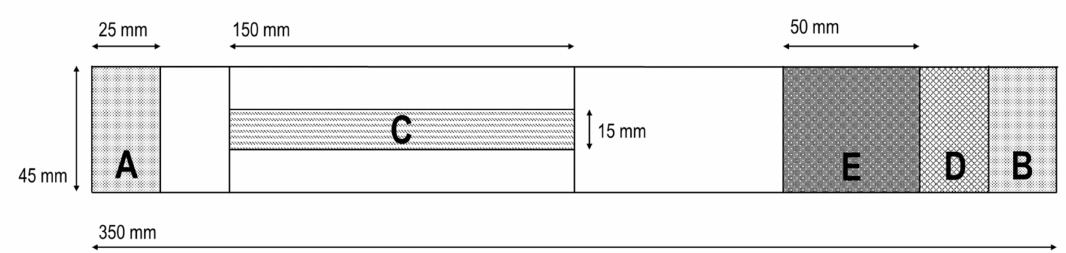
Figure 1. Sample preparation and tests from cut lamellae: ( A ) pre-thermo-hydro mechanical (THM) treatment density and moisture content (MC) tests, ( B ) post-THM treatment density and MC test, ( C ) modulus of elasticity (MoE) and modulus of rupture (MoR) tests, ( D ) set-recovery after soaking tests, and ( E ) Brinell hardness